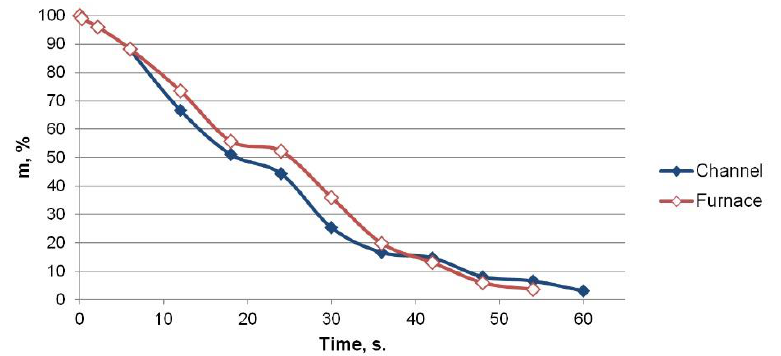
Figure 15. The change in particle mass over time at a furnace temperature of 800 °C and air flow velocity of 20 m s −1 .